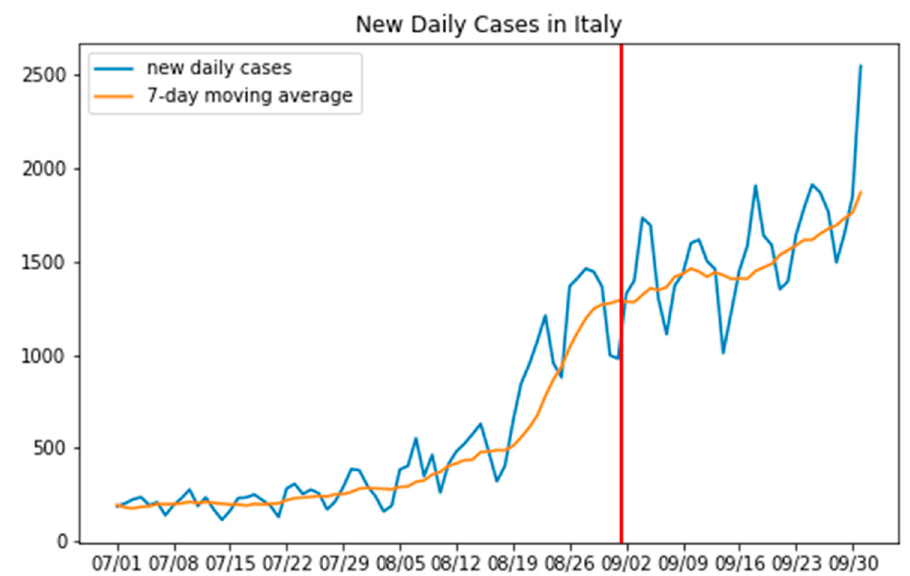
Figure 5. Number of new daily infection cases in Italy (blue), their 7-day moving average (orange), and the average national change point (red), falling on 1 September.